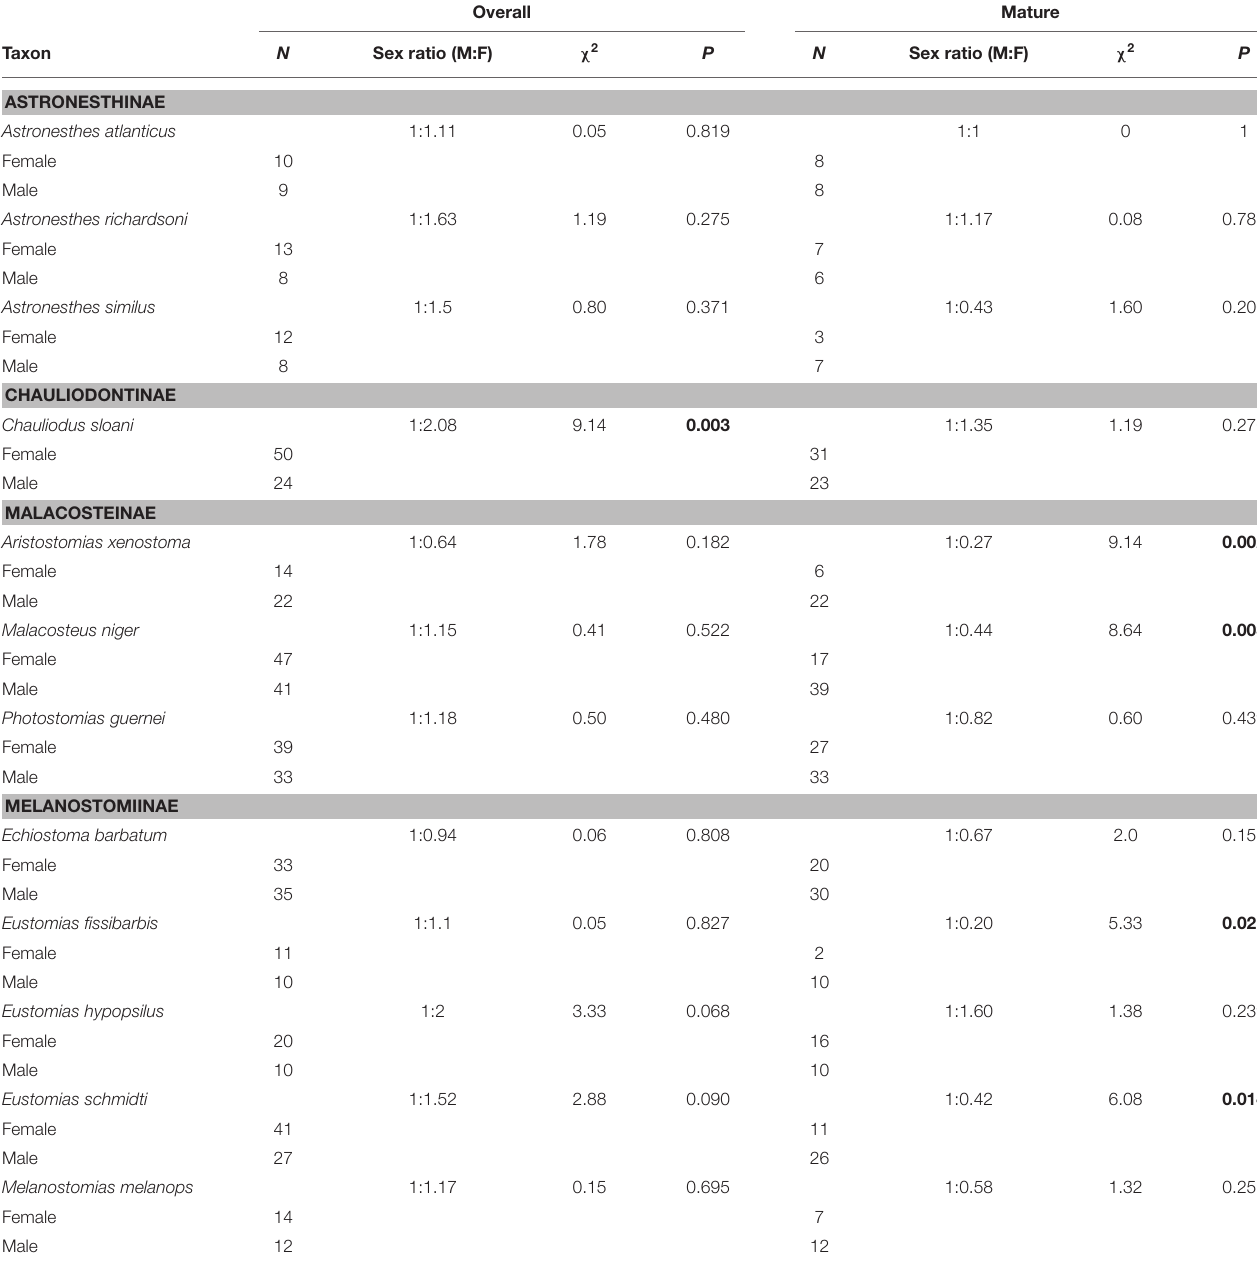
TABLE 3 | Overall and mature sex ratios of 12 dominant stomiids in the Gulf of Mexico, listed by subfamily. Overall